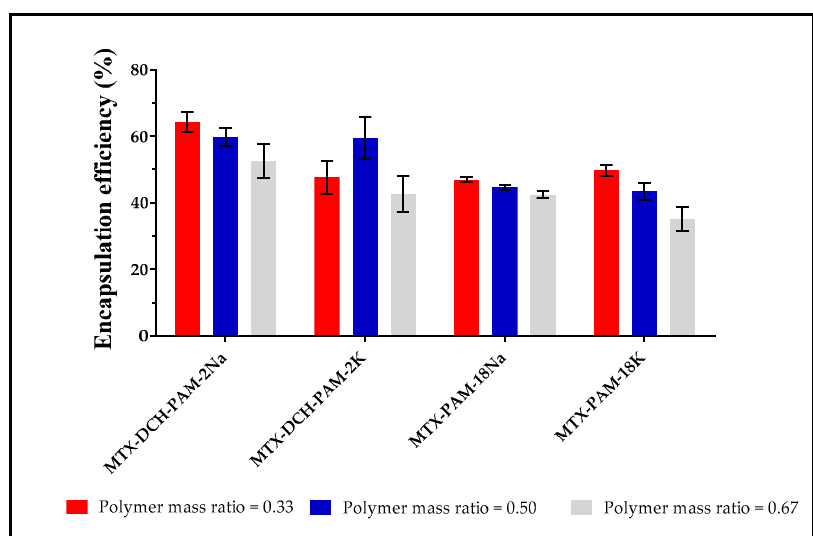
Figure 3. Encapsulation e ffi ciency for nanosystems formed between deacetylated chitosan and several polyanions.